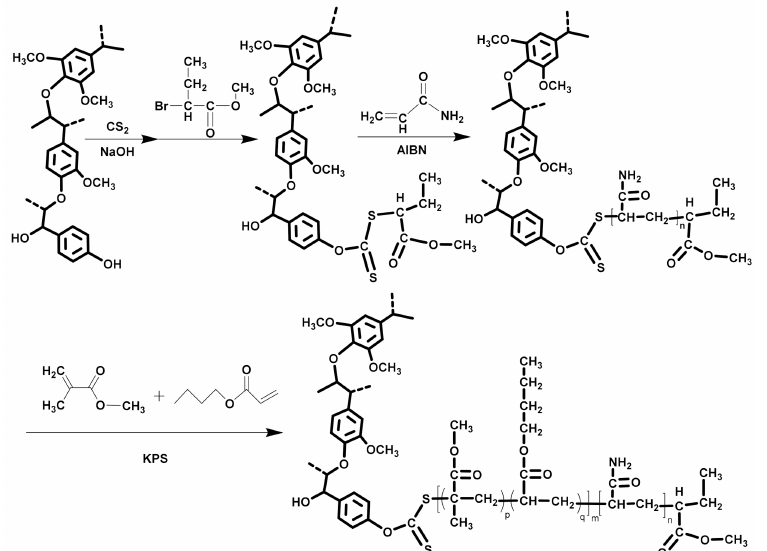
Figure 1. Schemes for the synthesis of lignin-graft-polyacrylamide (lignin-g-PAM) and methyl methacrylate copolymerized with butyl acrylate (lignin-based MMA- co -BA) hybrid resins.